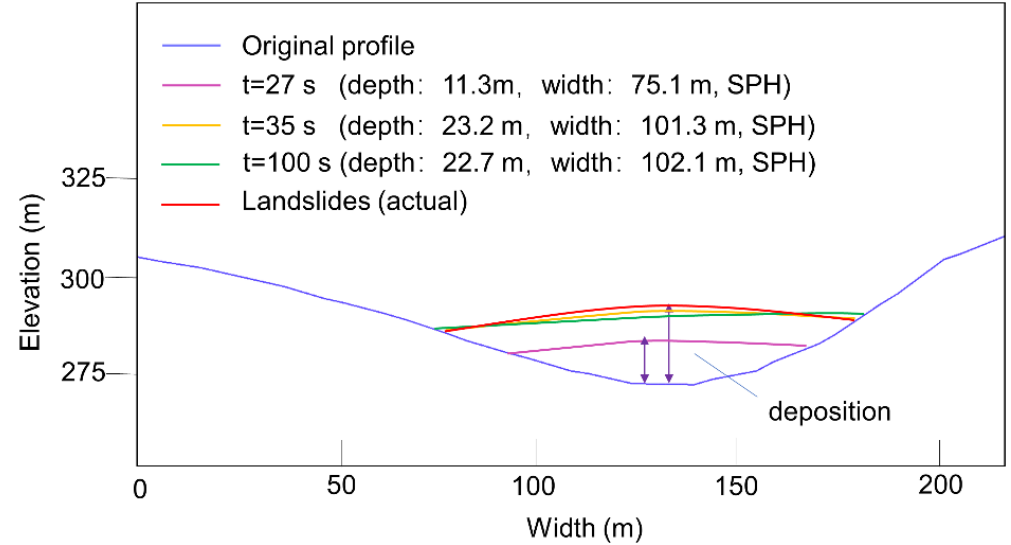
Figure 15. Comparison of profiles by the SPH simulation and the actual landslides along Section 2–2.